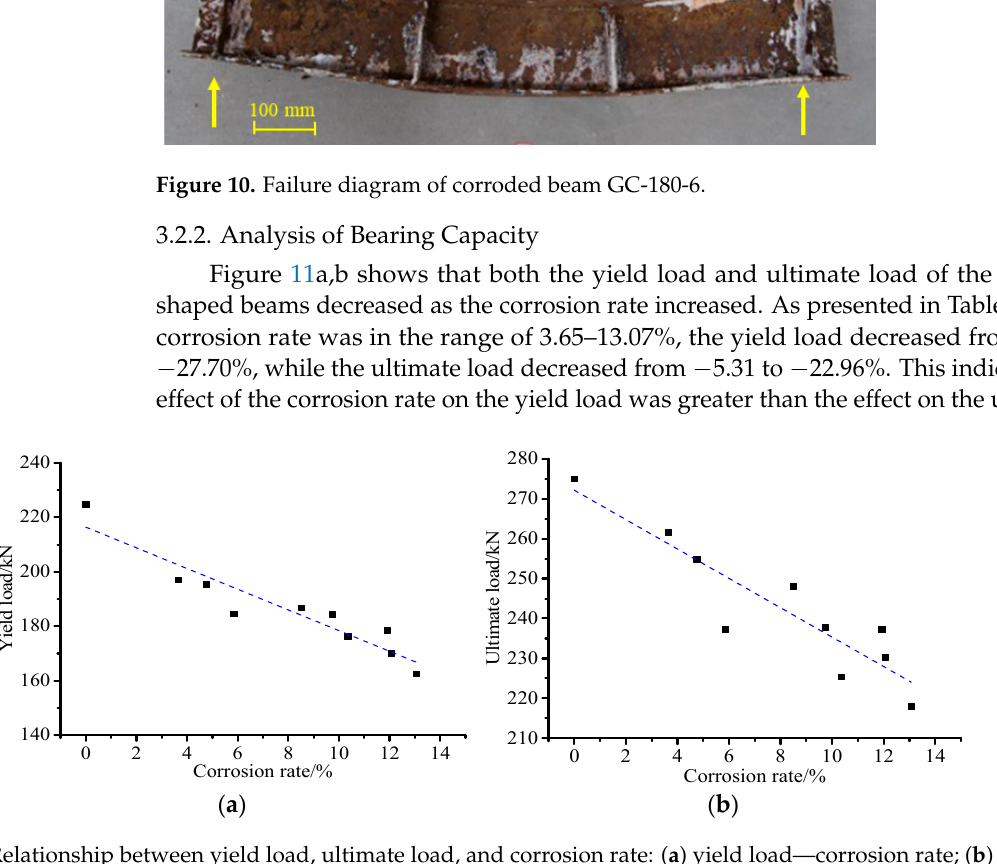
Figure 11. Relationship between yield load, ultimate load, and corrosion rate: ( a ) yield load—corrosion rate; ( b ) ultimate load—corrosion rate.